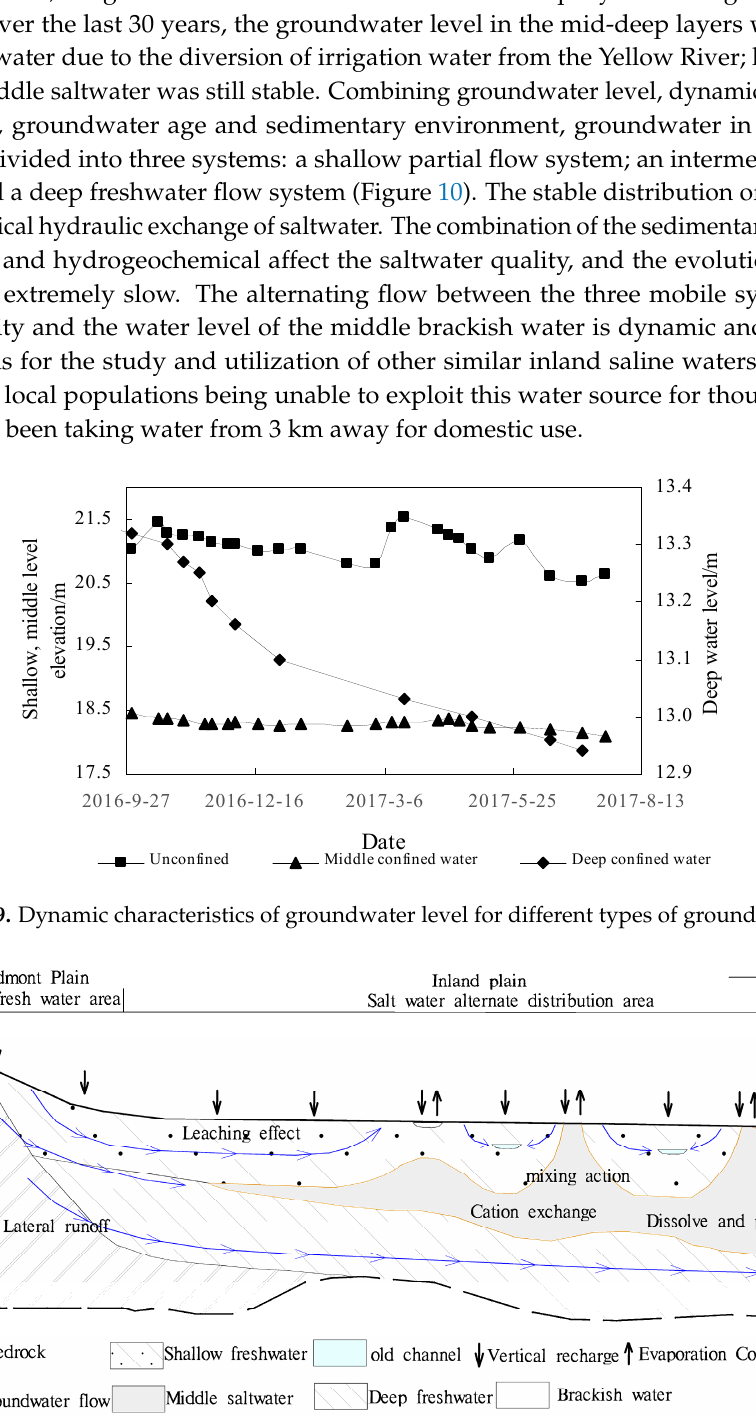
Figure 10. The sketch map of the vertical and horizontal zoning of water chemistry in the study area.